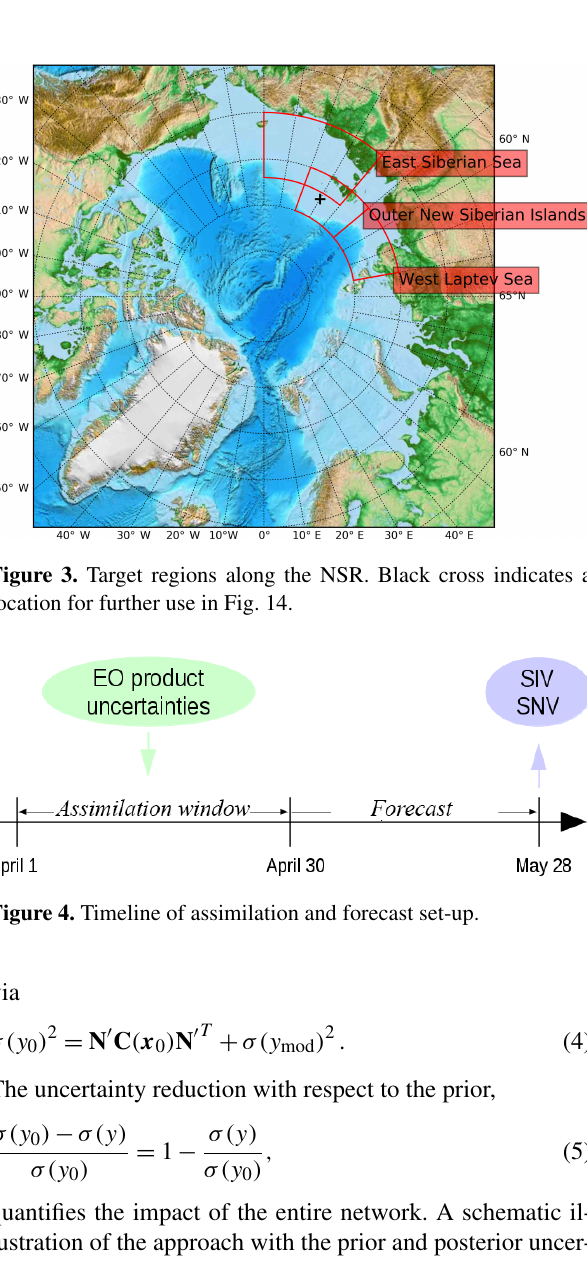
Figure 1. Data flow through a two-step procedure of QND formalism. Oval boxes denote data; rectangular boxes denote processing. “Back- ward propagation with inverse model” implements Eq. (1), and “forward propagation with model” implements Eq. (3). Figure taken from Kaminski and Rayner (2017).